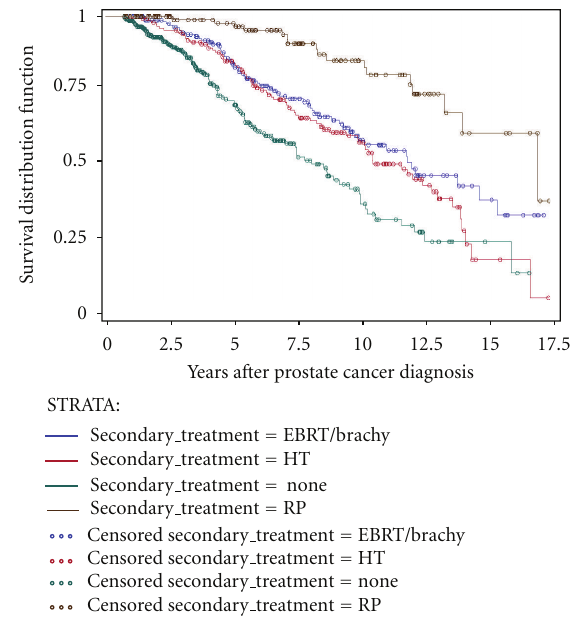
Figure 2: Kaplan Meier unadjusted estimation curve for overall survival stratified by secondary treatment type among subjects with prostate cancer (CaP) followed on active surveillance (AS) for primary treatment ( N =